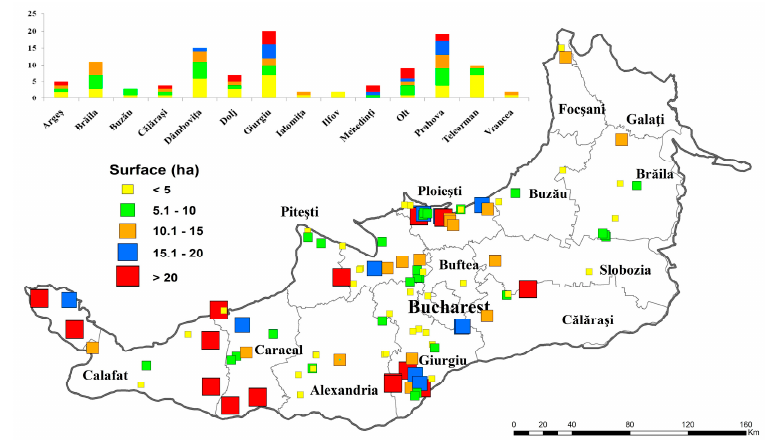
Figure 4. Surface and spatial distribution of PV farms at the county level.